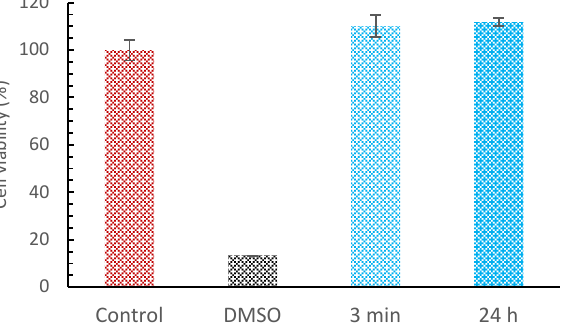
Figure 6. Polyester in vitro cytotoxicity or cell viability of HaCaT cells exposed to media conditioned with polymer discs, for 3 min and 24 h.